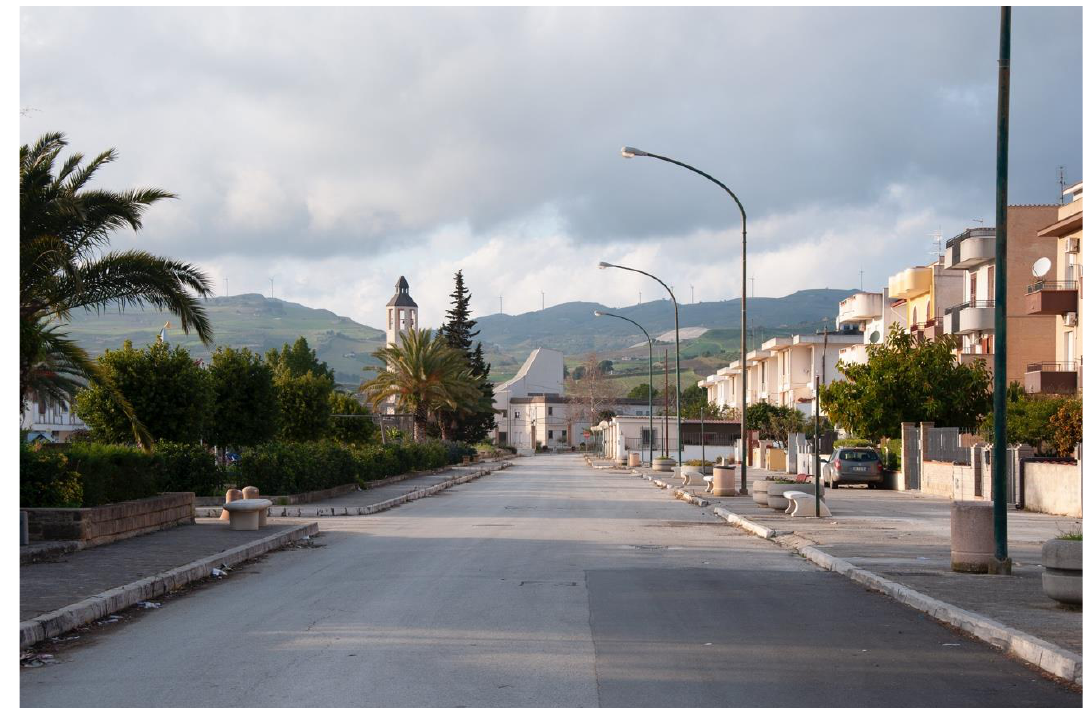
Figure 11. Salaparuta city center. The “new” Chiesa Madre is visible in the background. Photo by the authors, Salaparuta 2020.